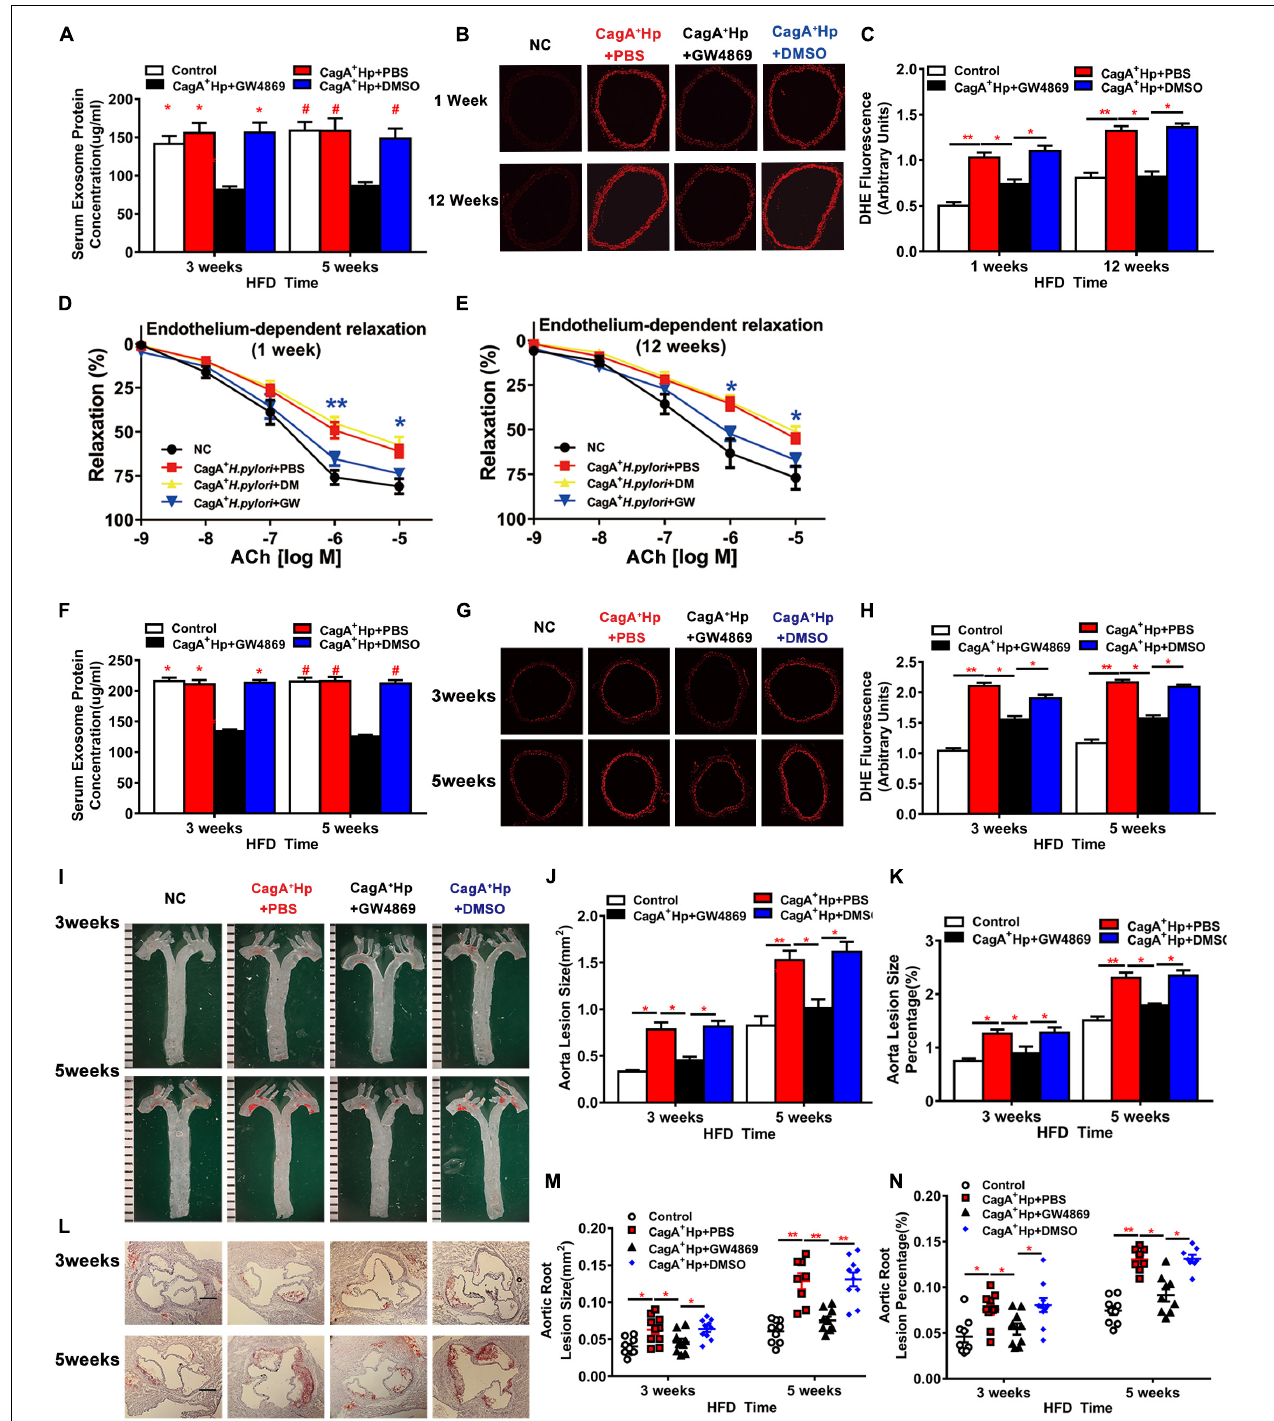
FIGURE 6 | Blocking exosomes release with GW4869 prevented endothelial dysfunction and atherosclerosis in mice with CagA + H. pylori infection. Treatment with GW4869 significantly decreased the serum exosome level (A) and ROS formation in thoracic aorta (B–C) with improved ACh-induced aortic relaxation (D,E) (* P < 0.05, ** P < 0.01, CagA + H. pylori vs. CagA + H. pylori + NAC by one-way ANOVA) in C57BL/6 mice with CagA + H. pylori infection. GW4869 treatment also significantly decreased serum exosomes level in LDLR − / − mice with CagA + H. pylori infection (F) . After 3 or 5 weeks of high-fat diet (HFD), ROS formation (G,H) and atherosclerotic plaque formation in aorta and aortic root (I–N) were significantly increased in LDLR − / − mice with CagA + H. pylori infection that were prevented with GW4869 treatment. NC: normal control; ACh: acetylcholine; CagA + Hp: CagA + H. pylori ; DMSO: dimethylsulfoxide (solvent for GW4869). Data are presented as mean ± SEM. * P < 0.05, ** P < 0.01 by one-way ANOVA, N = 8–10 mice for each group at each time point.